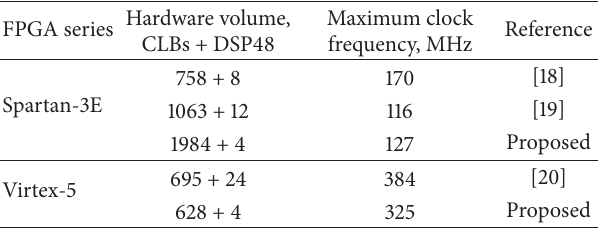
Table 2: 64-point FFT processors configured in Xilinx FPGAs.